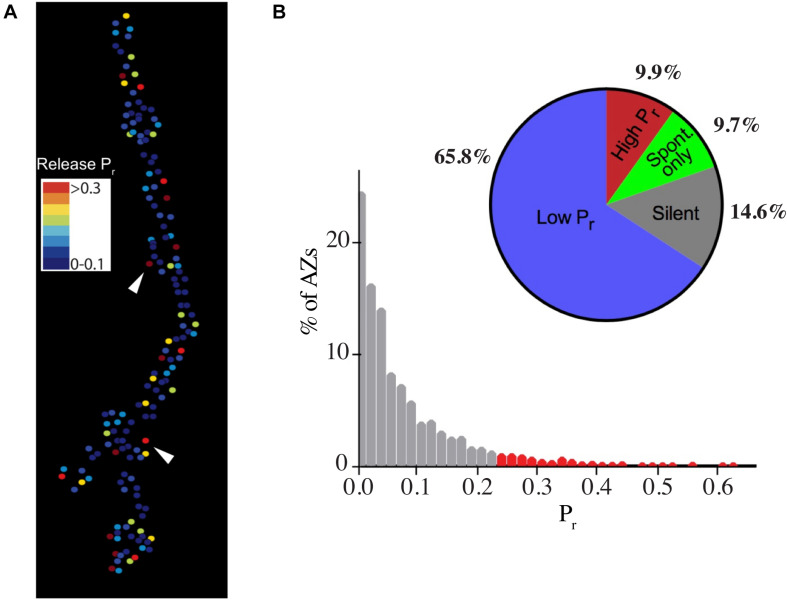
Heterogeneity in synaptic transmission strength of individual AZs at Ib motoneuron terminals. (A) Heat map for evoked AZ Pr at Ib NMJs at 3rd instar muscle 4 determined by optical quantal imaging with post-synaptic myristoylated GCaMP6s. Stronger AZs are shown in red with weaker AZs displayed in the colder blue colors. Arrowheads denote several high Pr AZs. (B) Histogram of AZ Pr distribution for 0.3 Hz stimulation for 5 min for Ib motoneurons. AZs classified as high Pr (>2 standard deviations above the mean) are shown in red. The pie chart shows the percentage of overall AZs from multiple NMJ optical imaging sessions that represent low Pr (65.8%), high Pr (9.9%), spontaneous-only (9.7%), or silent (14.6%) AZs for the Ib motoneuron population innervating muscle 4. Note the pie chart colors are unique and do not reflect the Pr heatmap. Panels (A,B) are modified from Akbergenova et al. (2018).